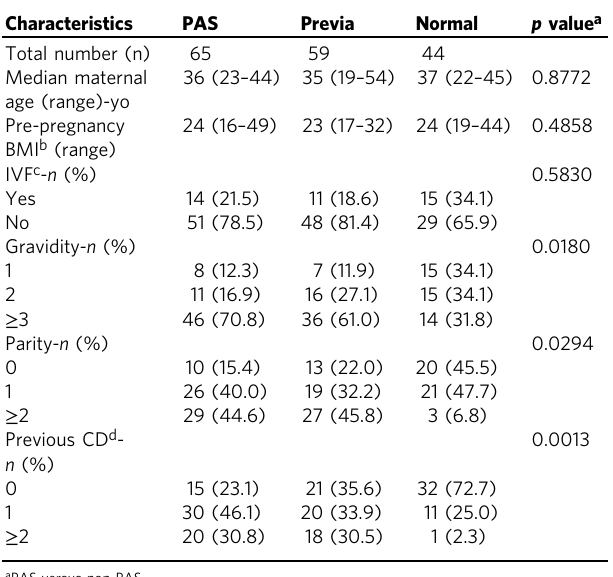
Table 1 Clinical information for pregnant women ( n = 168) enrolled in the